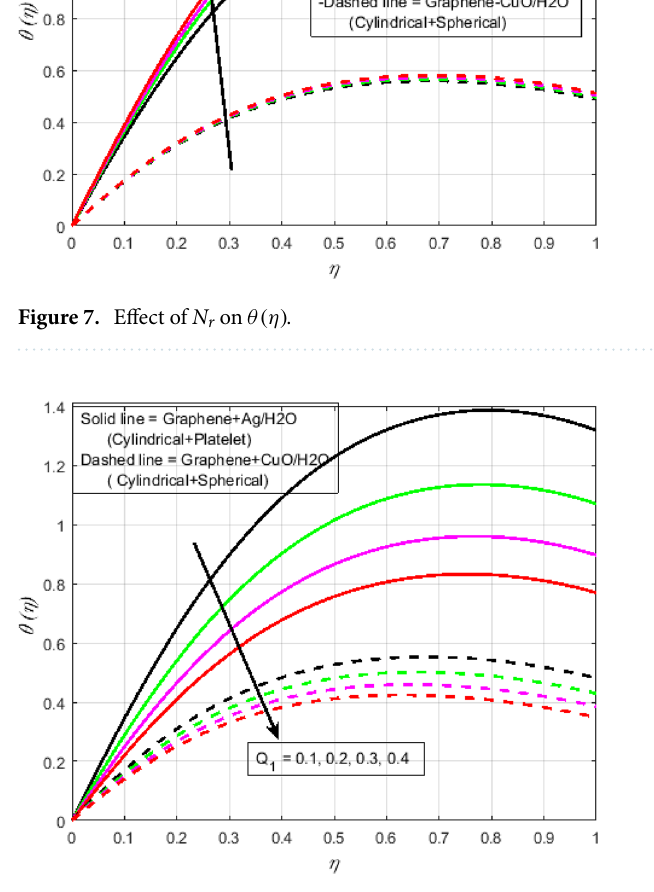
Figure 8. Effect of Q 1 on θ(η)